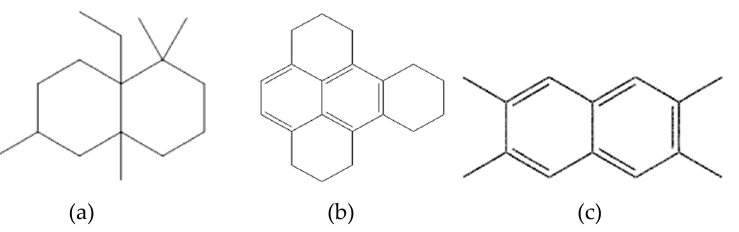
Figure 7. The structure of ( a ) 8a-Ethyl- 1,1,4a,6-tetramethyldecahydronaphthalene; ( b ) 1,2,3,6,7,8,9, 10,11,12-Decahydrobenzo[e]pyrene; and ( c ) 2,3,6,7-Tetramethylnaphthalene.